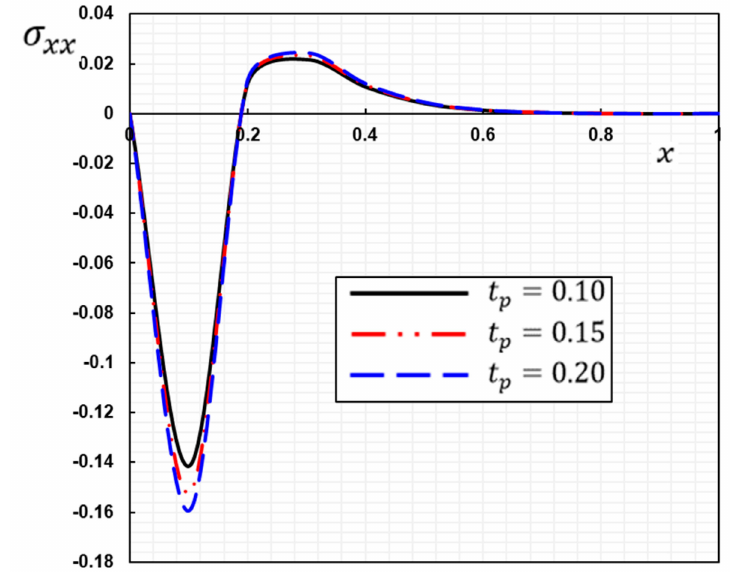
Figure 6. Variation of thermal stress σ xx against laser pulse duration t p